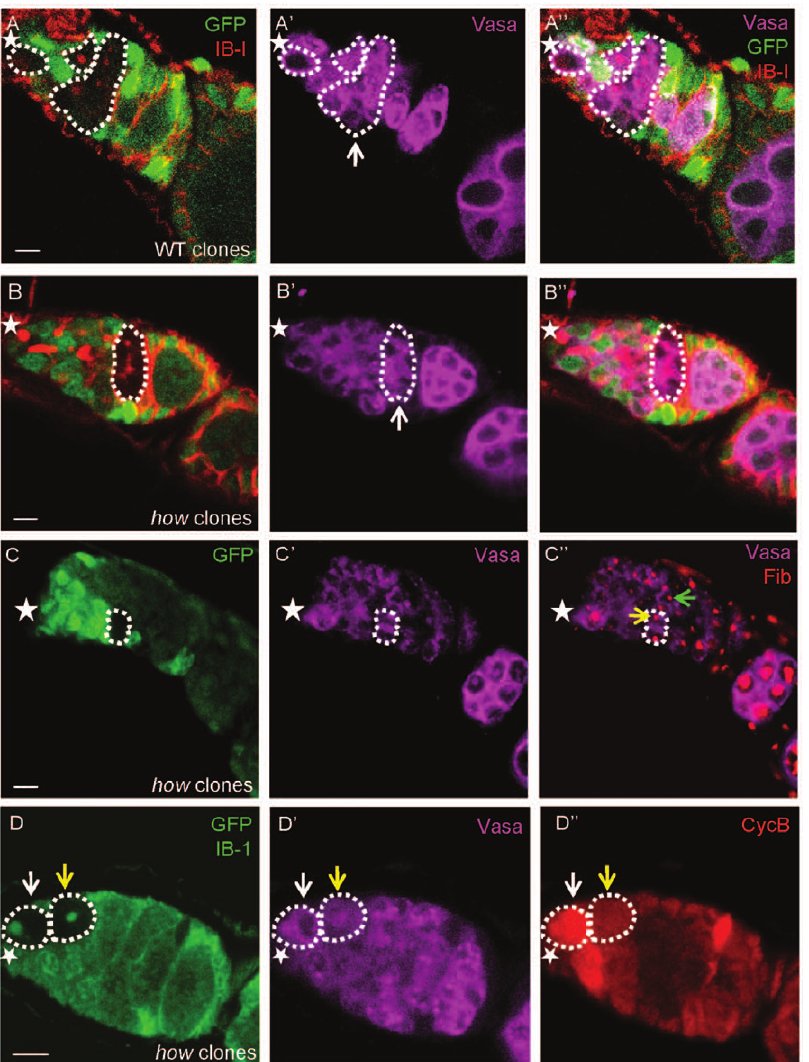
Figure 3. HOW is not required for germ cell mitoses in the female germline. ( A,B ) Comparison of germaria containing wild type germ cell clones (A, white dotted line) and how stru germ cell clones (B, white dotted line). ( A ) Five days post-clone induction, wild type clones derived from wild type GSC clones have reached the 16-cell stage (white q ). ( B ) how stru germ cell clones derived from how stru GSC clones progress to the 16-cell stage (white q ), as seen by the branched fusome (red) connecting Vasa-positive (magenta) clonal germ cells. ( C ) Germ cells lacking HOW do not show morphological defects. Five days post-clone induction, how clonal cystocytes can be observed (white dotted line). ( C’’ ) Anti-Fibrillarin stains the nucleolus (red). Nucleolar size in how clonal cystocytes (yellow q ) is similar in size compared to the nucleoli in control cystocytes at a similar stage in development (green q ). ( D ) Female germ cells lacking HOW are able to produce CycB protein. Wild type (non-clonal, GFP-positive) GSCs and cystocytes up to the 8-cell stage display oscillating levels of CycB. ( D ’– D’’ ) how GSCs (white q ) and cystocytes (yellow q ) can express CycB (red) at normal oscillating levels. Anterior marked (*). Scale bar 5 m m.